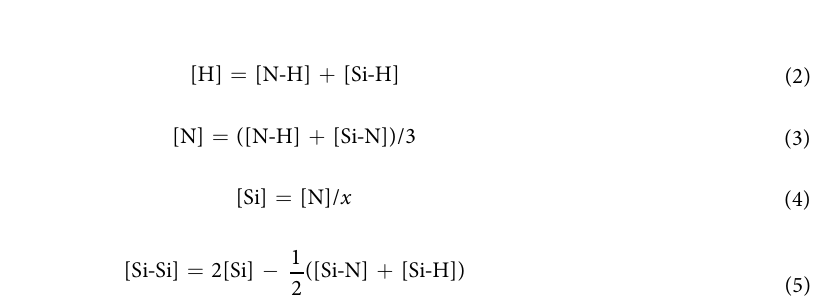
Figure 2. ( a ) N/Si ratio as a function of the Si x N y layer refractive index; ( b ) Bond concentrations for each Si x N y layer configuration; ( c ) Hydrogen content (in atomic %) for each Si x N y layer